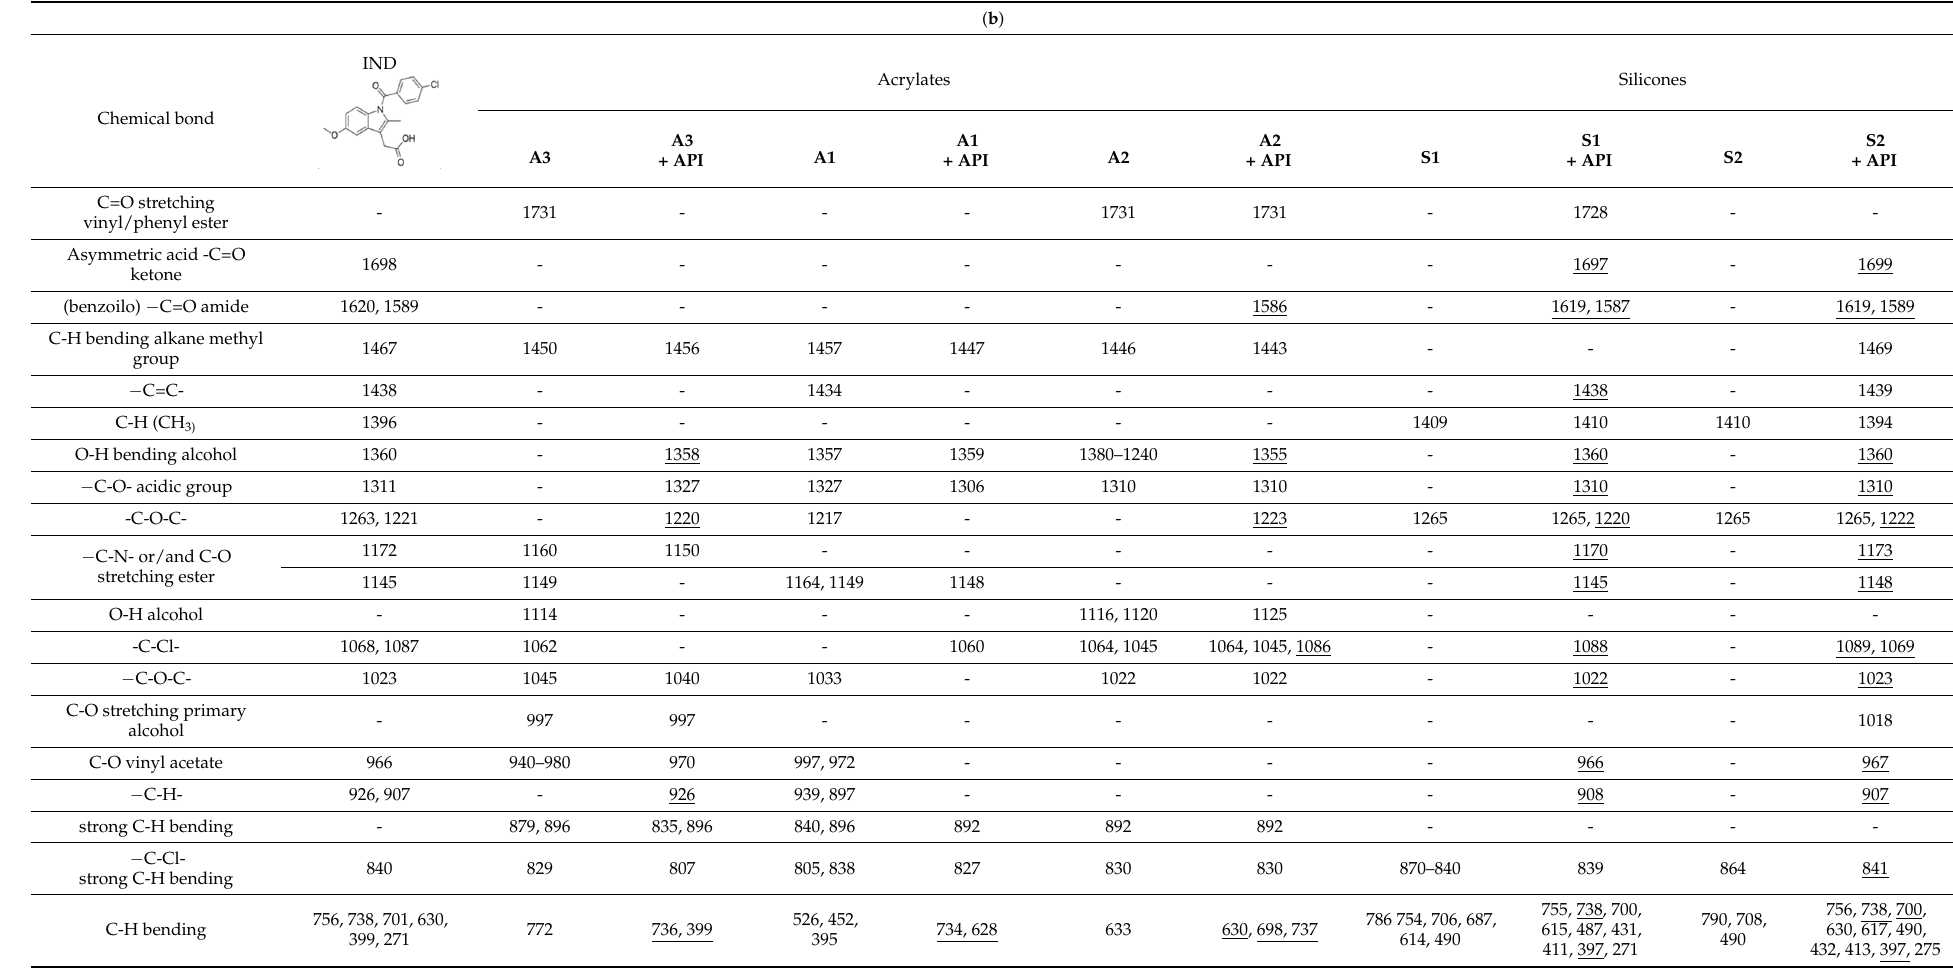
Figure 1. FTIR spectra of the investigated placebo patches: ( a ) polyacrylates; and ( b ) polysiloxanes. The grey bands mark differences or similarities between the polymers’ spectra. Table 3. FTIR identification of IND (a), CYT (b) and TST (c) in the polymeric matrices (bands or wavenumber ranges underlined are characteristic of API identification in respective patches and Table 4. Cont. not present in placebo polymer film)